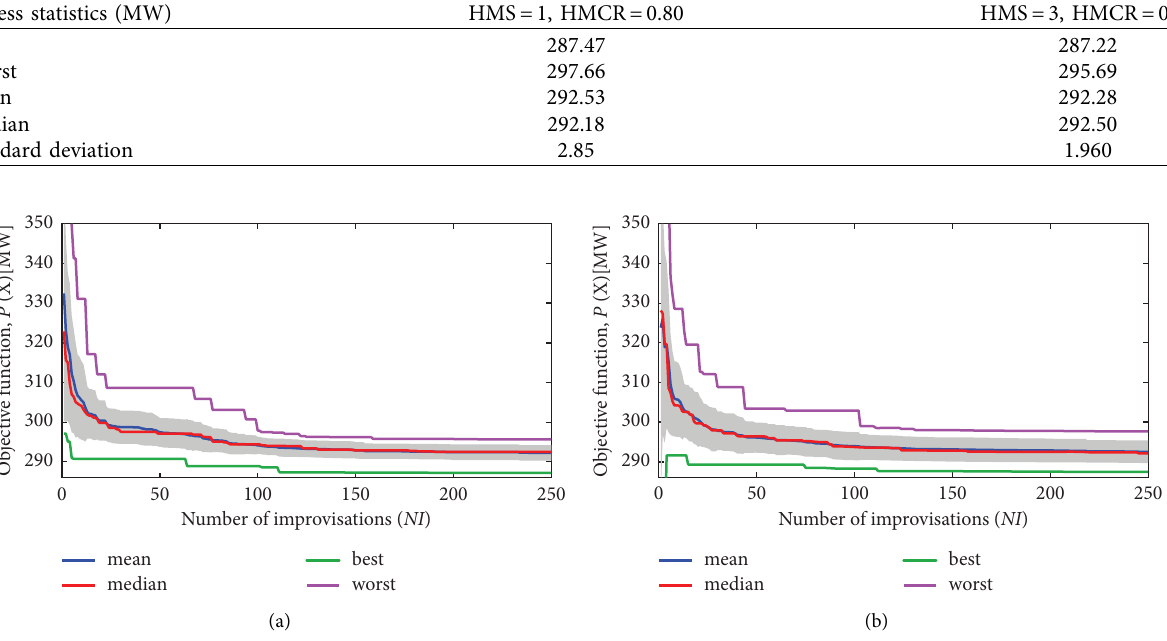
Figure 8: Best, worst, mean, median, and standard deviation (gray area) for ftness in each improvisation using: (a) HMS � 1.0, HMCR � 0.80 and (b) HMS � 3, HMCR � 0.85.